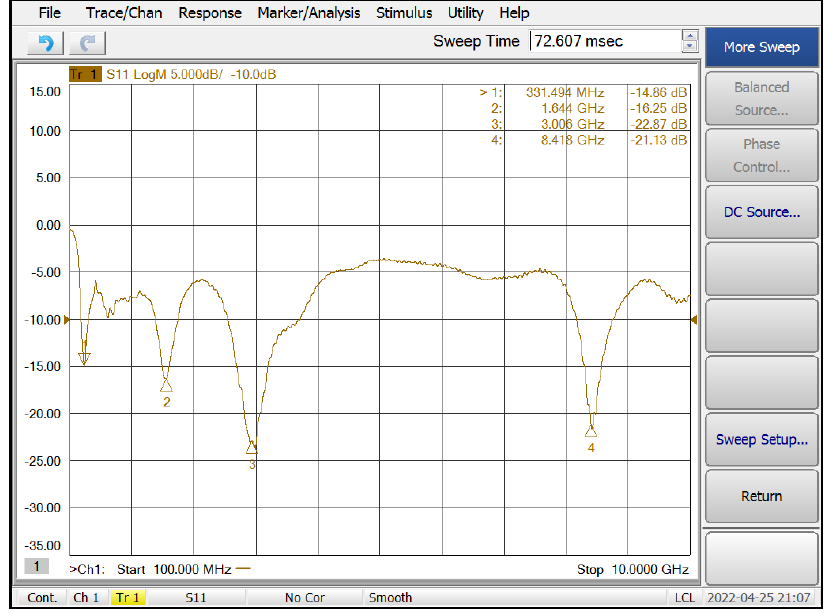
Figure 2. Parameter S 11 in dB corresponding to the third–iteration Sierpinski fractal dipole.